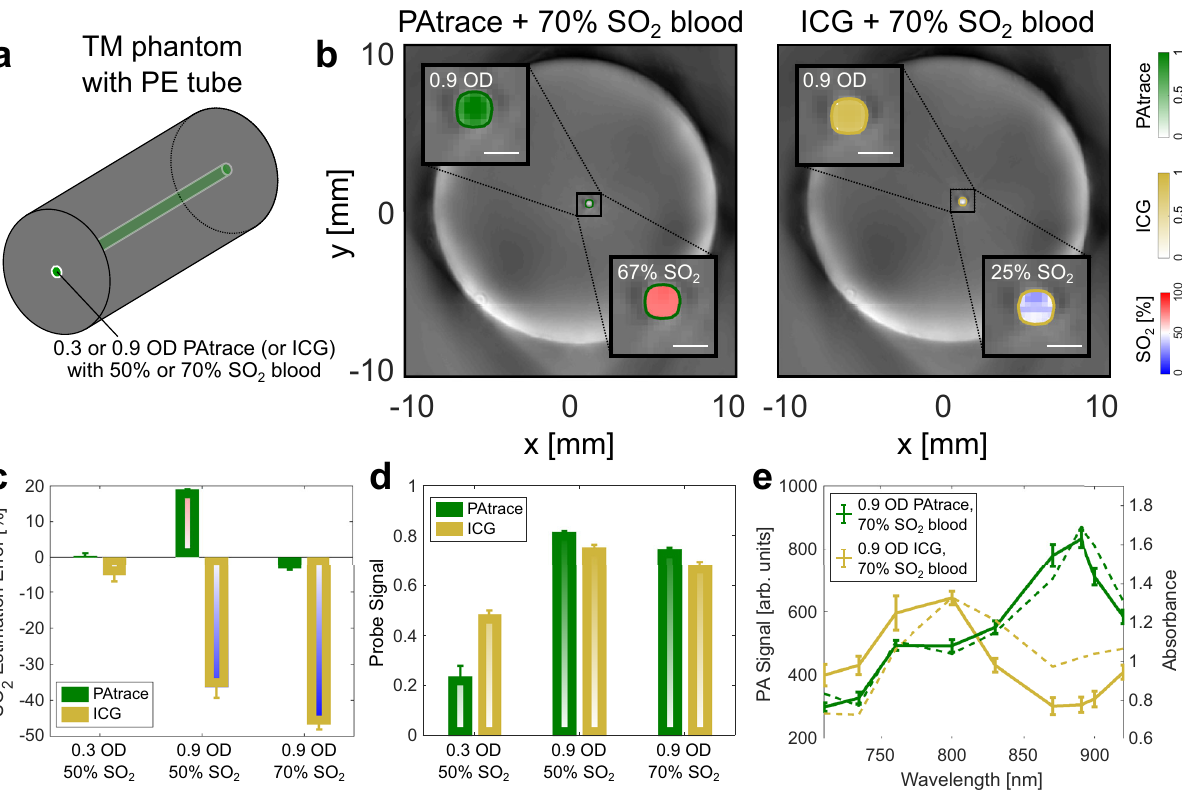
Fig. 3 Phantom comparison of PAtrace and ICG in blood-containing phantom. a Schematic of tissue-mimicking (TM) phantom for multi-wavelength PA imaging with an embedded polyethylene (PE) tube for assessment of combinations of PAtrace (or ICG) with blood. b 800nm PA axial images of TM phantom with insets showing SO 2 and PAtrace (or ICG) images of the target region for 0.9 OD PAtrace/70% SO 2 blood (left) and 0.9 OD ICG/70% SO 2 blood (right); color bars for each inset shown on the right. Note that PAtrace and ICG are readily unmixed in their respective insets; however, there is a large error in SO 2 estimation in the phantom with ICG, which is not observed in the phantom with PAtrace. White scale bar indicates 0.5 mm. c PA-based SO 2 estimation error for all concentration/SO 2 combinations tested yield <20% absolute error for PAtrace (green bars), while yielding nearly 50% error in presence of ICG (gold bars). d PAtrace signal increases by a factor of 3.3 with a 3-fold increase in concentration, whereas ICG signal only increases by a factor of 1.4 with a 3-fold increase in concentration. e Spectral data from multi-wavelength PA acquisitions in ( b ) are shown by solid lines (error bars indicate mean ± SD across 12 z-slices), while theoretical spectra for these combinations are indicated by dashed lines. All phantom combinations were fabricated and imaged